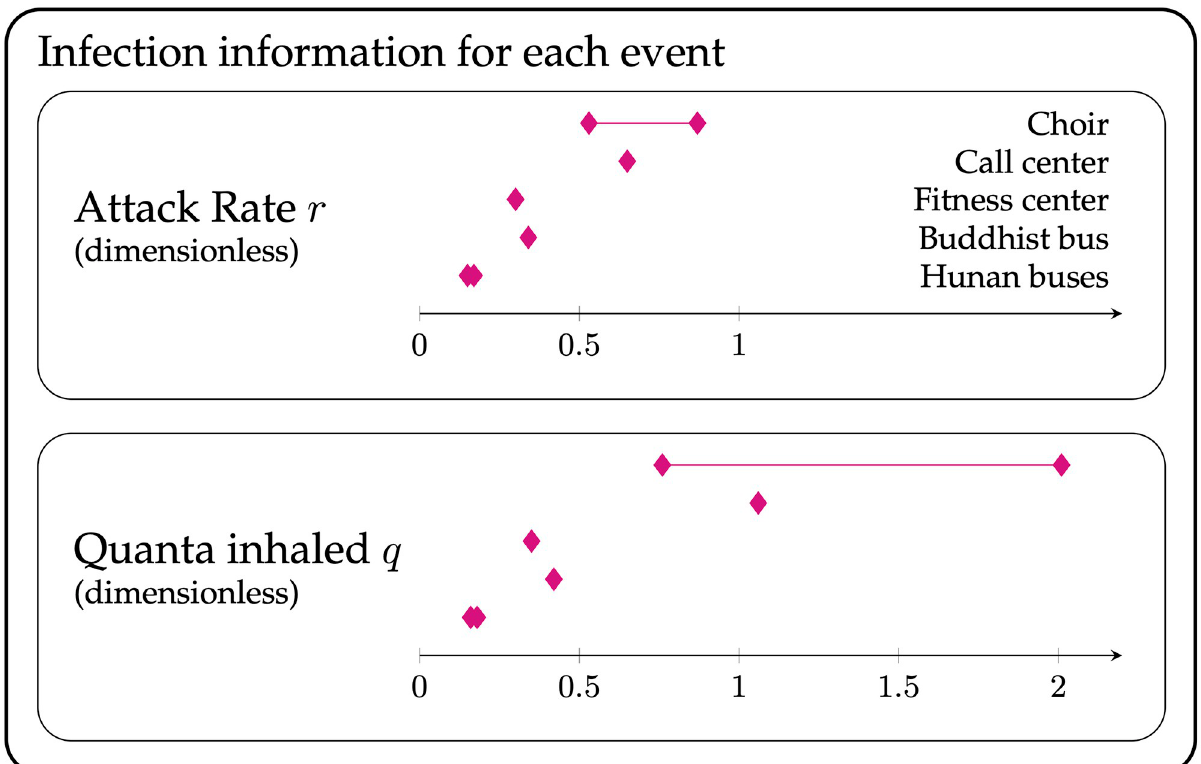
Fig 3. Attack rate r (infected / exposed) and quanta inhaled q = − ln(1 − r ) for each of the five events. In the case of the choir, the smaller attack rate includes only confirmed cases, while the larger attack rate includes both confirmed and probable cases [5]. In the cases of the Hunan buses, the range spans the two bus